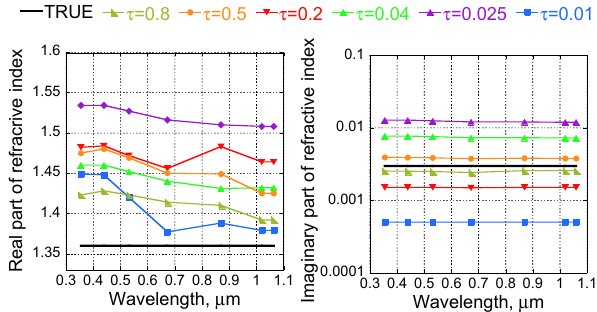
Fig. 7. Retrievals of complex refractive index of the “Smoke” aerosol model under different